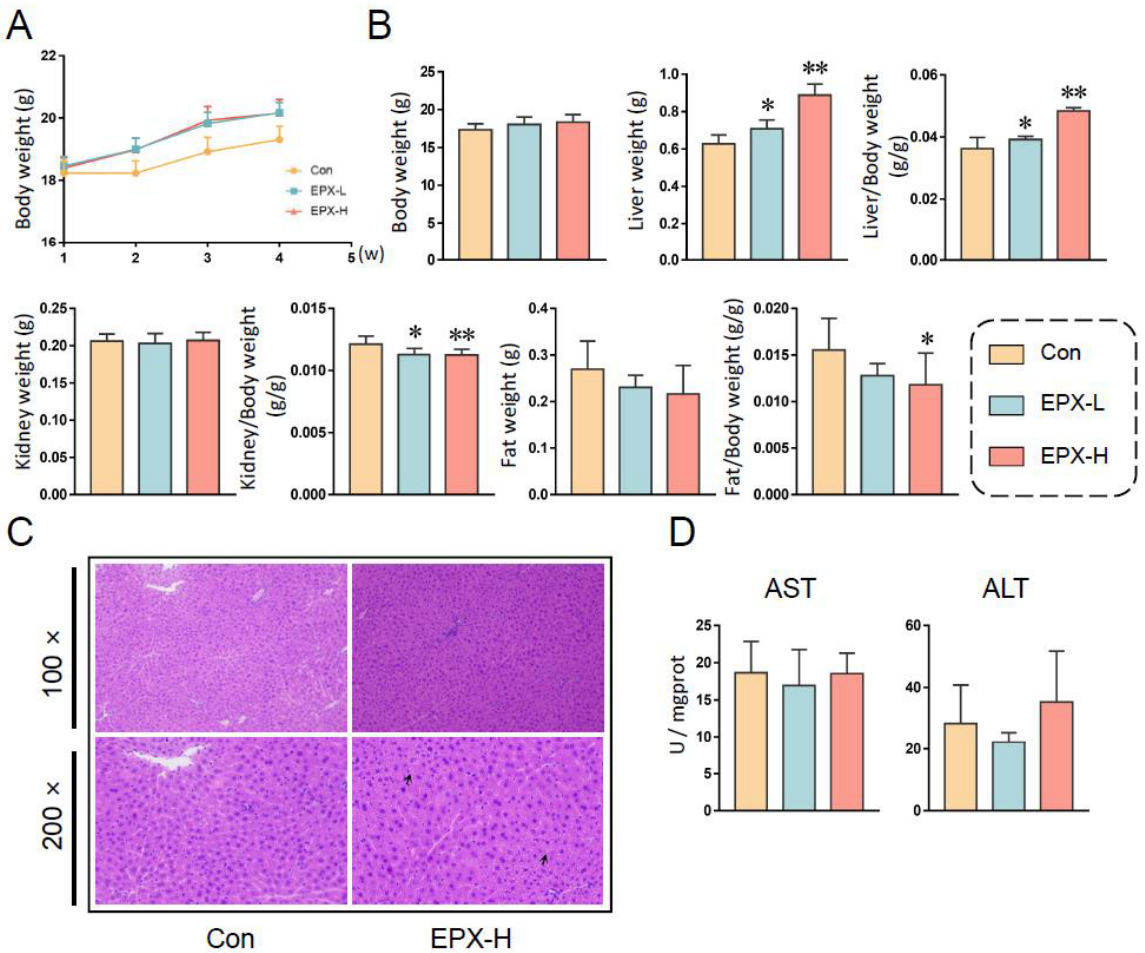
Figure 1. Effects of the oral exposure to EPX on the growth phenotype of mice. ( A ) The body weight of mice in each group weekly during exposure. ( B ) The body weight and organ weight of mice on the day of dissection. ( C ) The H&E staining of the liver. Black arrow: vacuolation. ( D ) Serum liver function indicators: AST activity, ALT activity. Values are shown as the means ± SEM ( n = 8), and statistical significance: p < 0.05 *; p < 0.01 **. Table 1. Effects of EPX exposure on the biochemical indicators of